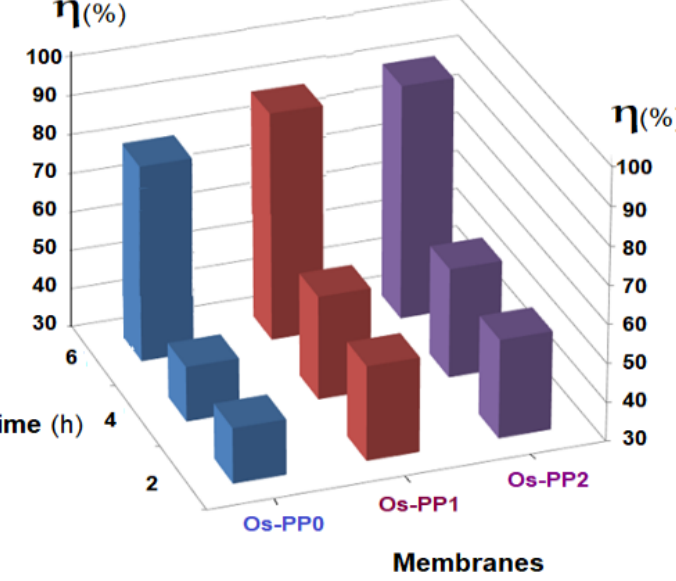
Figure 14. Influence of membrane type (Os-PP0, Os-PP1 and Os-PP2) on the conversion ( η %), to the reduction of p- nitrophenol in tert- butyl alcohol solution as a function of operating time (h).